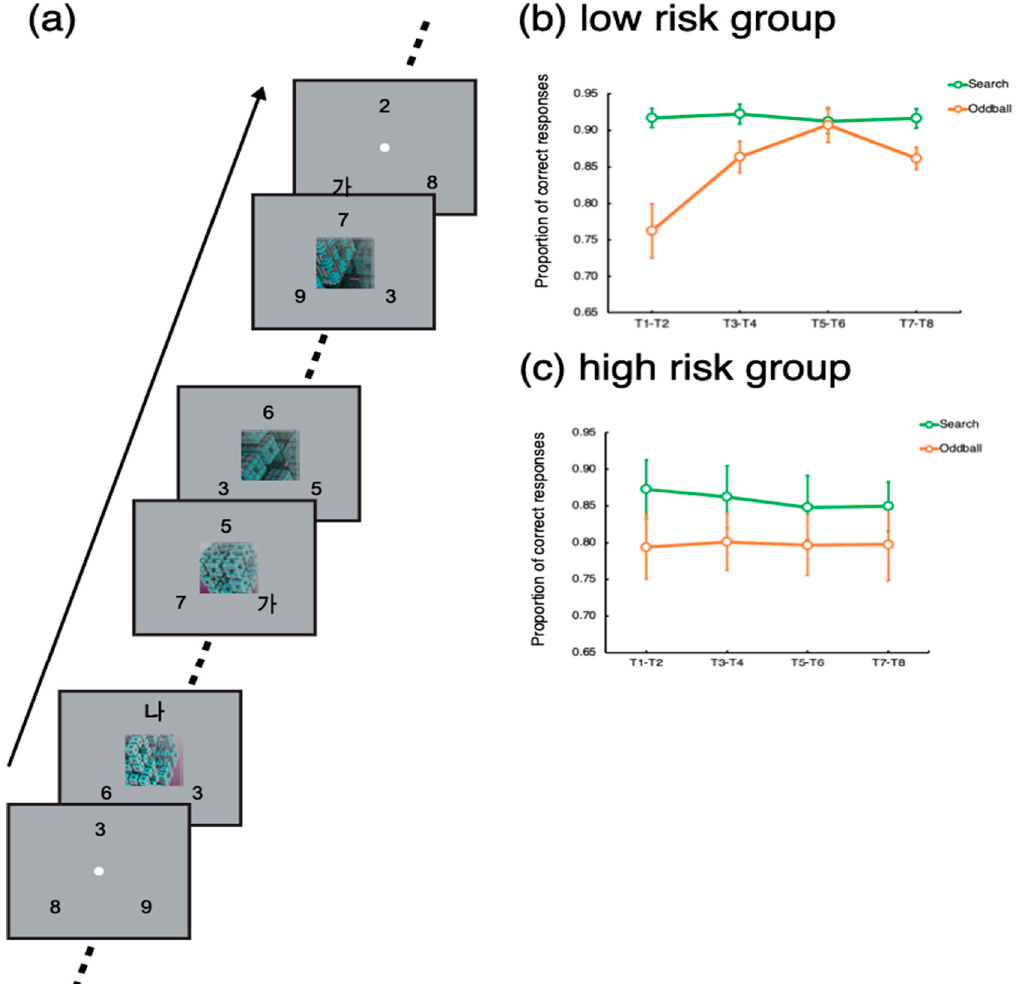
Figure 1. Trial design and behavioral results. ( a ) Trial design. ( b ) Behavioral results of the low-risk group participants. ( c ) Behavioral results of the high-risk group participants. Error bars represent standard errors of the mean.